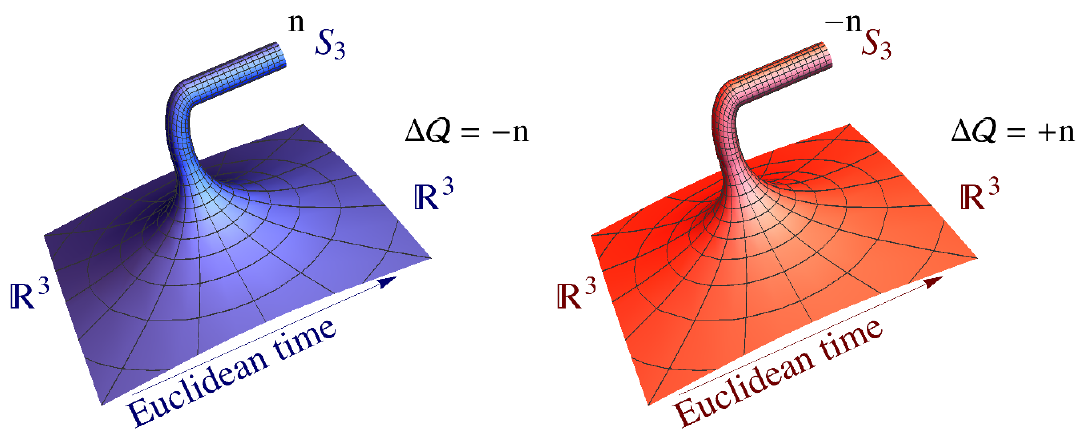
Figure 3 . Half-wormholes as instantons in Euclidean space. In the left (right) panel we show an instanton (anti-instanton) mediating the topology change R 3 ! R 3 (cid:8) S 3 , and carrying away an axion charge + n ( (cid:0) n ). The axion charge is overall conserved but an observer on R 3 experiences, as Euclidean time passes by, a change (cid:1) Q = (cid:0) n ((cid:1) Q = + n ). The non-conservation of the axion charge Q on R 3 implies an explicit breaking of the symmetry it